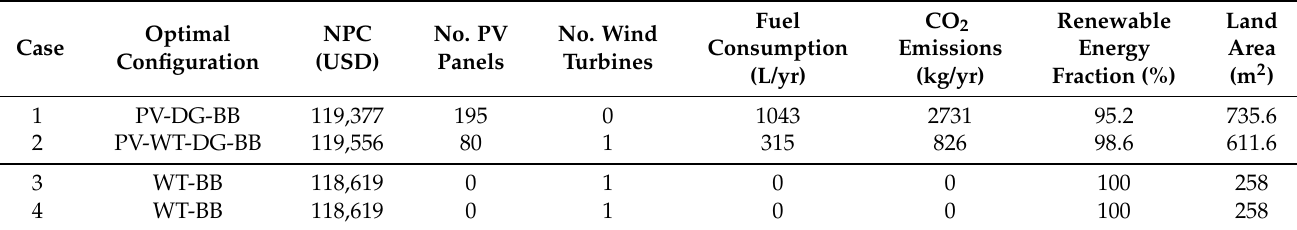
Table 20. Comparison of optimal configurations for Jal-Alayah